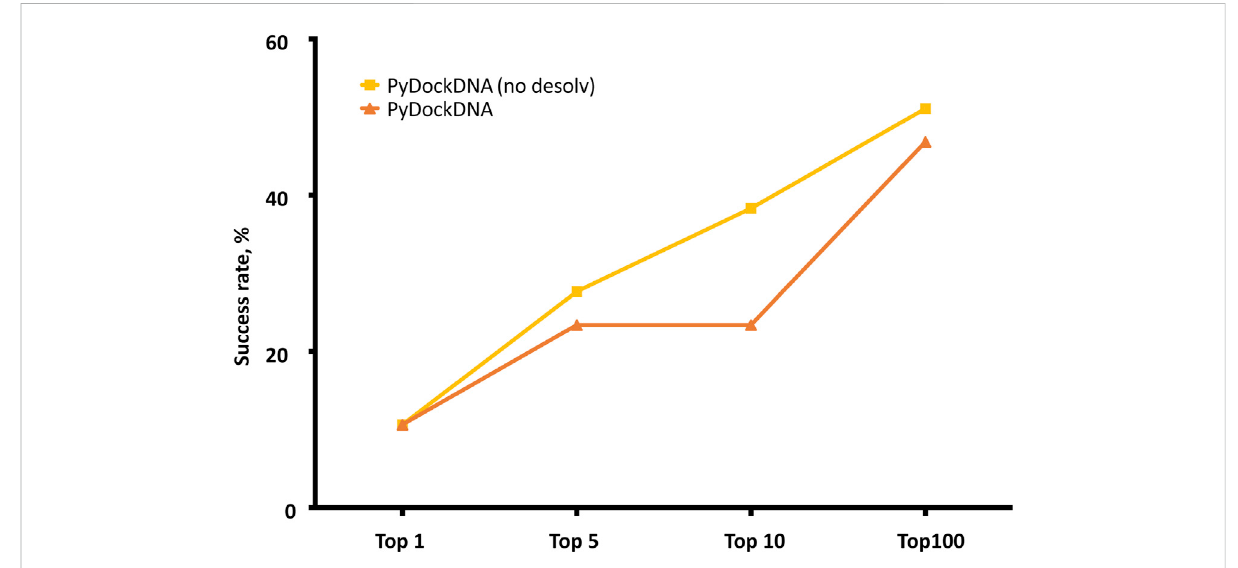
FIGURE 2 Predictive performance for the top N = 1, 5, 10, 100 models of pyDockDNA (with and without desolvation) on the protein-DNA docking